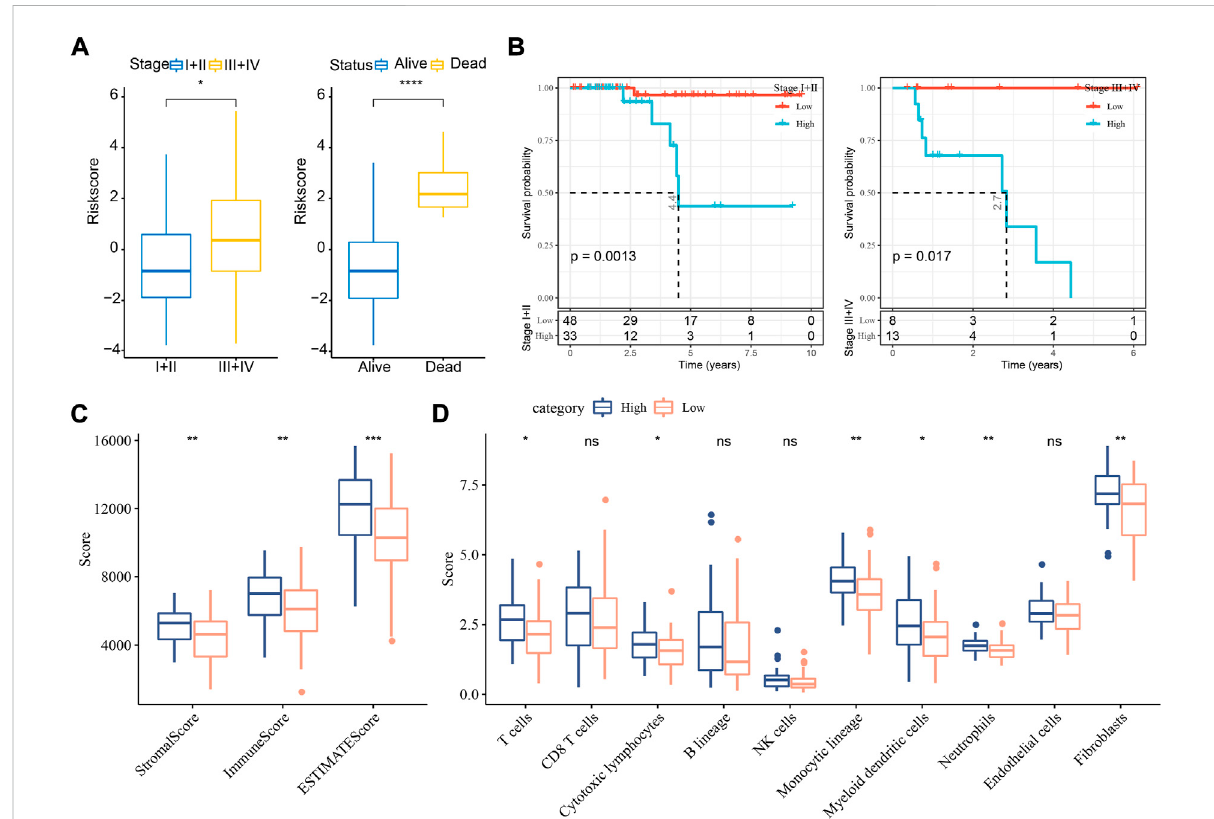
FIGURE 5 The relation of risk score to clinical features and immune in fi ltration in TCGA dataset. (A) The risk score in different stages and survival status. Student ttestwasconducted. (B) Kaplan-Meier survival analysis ofhigh- and low-risk groups with differentstages. Log-rank testwasconducted. (C) ESTIMATE analysis for calculating stromal score and immune score oftwo groups. (D) MCP-counter analysis for calculatingtheenrichment score of 10 immune cells. Student t test was performed. ns, not signi fi cant. * p < 0.05, ** p < 0.01, *** p < 0.001, **** p <